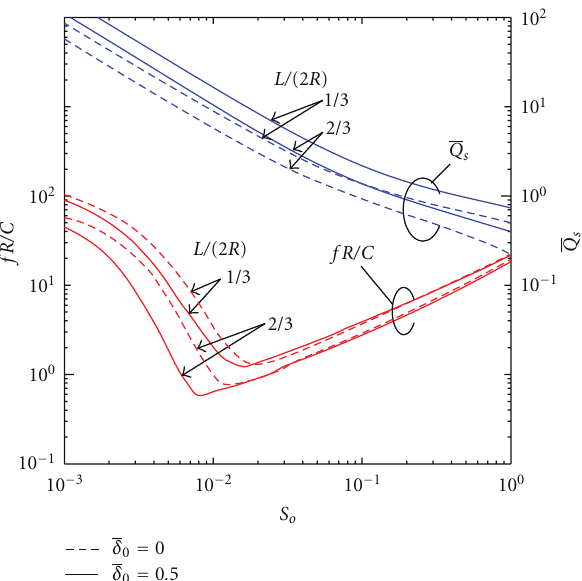
Figure 8: E ff ect of bearing-width ratio L /(2 R ) on frictional coe ffi - cient f R / C and side leakage flow rate Q number S o (no dent and δ o = 0.5).